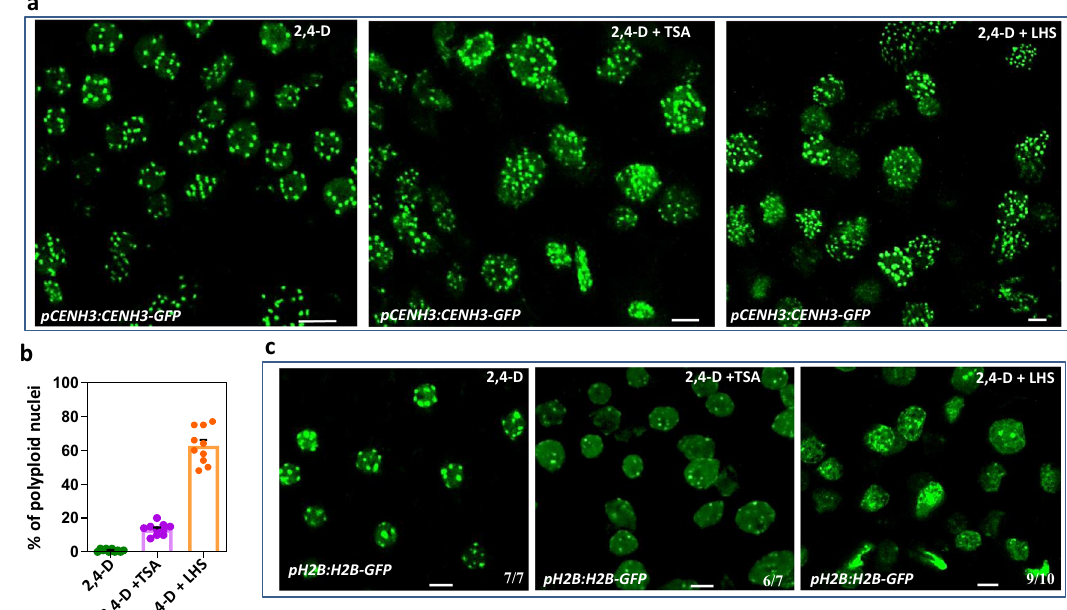
Fig. 6 TSA treatment or heat stress result in polyploidy in 2,4-D induced embryonic cells by promoting heterochromatin decondensation. a Confocal image of CENH3-GFP-labeled nuclei in protodermal cells at the adaxial side of IZE cotyledons after 9 DOC. IZEs were cultured for 9 days on medium with 2,4-D (left), or after 7 days on 2,4-D medium transferred for two days to medium with 2,4-D and 1 µ M TSA (middle), or exposed for 2 days to long heat stress (LHS) at 38 °C (right). b Percentage of polyploid nuclei (based on more than ten detectable CENH3-GFP-labeled centromeres) in cotyledon cells (shown in a ). Dots indicate the values of ten biological replicates per treatment with about 200 nuclei analyzed per replicate, bar indicates the mean, and error bars the s.e.m. c Visualization of heterochromatin decondensation in pH2B:H2B-GFP IZEs after 9 DOC on medium containing 2,4-D (left), or after 7 DOC on 2,4-D medium followed by 2 days on 2,4-D and 1 µ M TSA (2,4-D + TSA, middle), or by 2 days incubation at 38 °C (2,4D + LSH, right). Size bars indicate 6 µ m. a – c Similar results were obtained from two independent experiments. c Numbers in images indicate the frequency with which similar images from different samples were